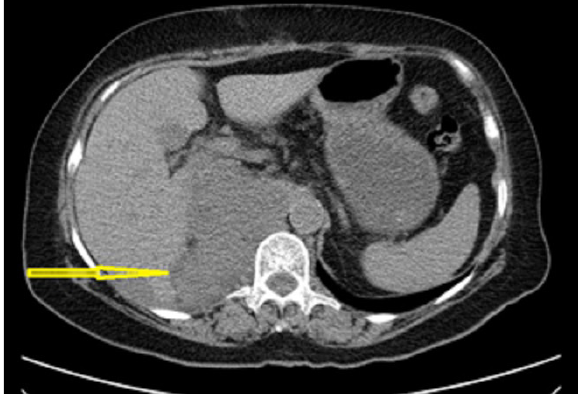
Figure 4: Postoperative abdominopelvic CT scan demon- strates local recurrence and liver metastasis